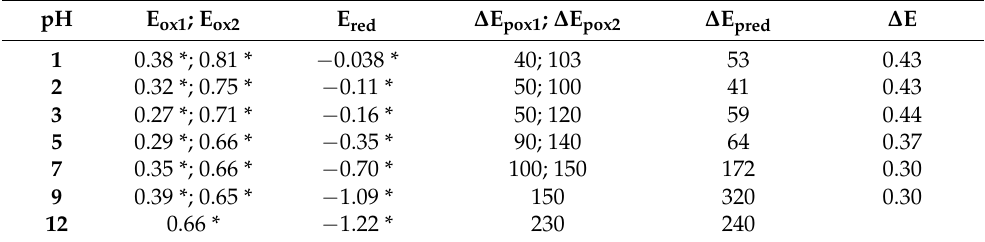
Figure 3. ( a ) Cyclic voltammogram of 0.5 mg ml − 1 N-CDs-160-8 and CG electrode in pH 7 buffer + 0.1 M NaClO 4 . Scan rate: 0.1 V s − 1 . Inset: Single-sweep voltammogram of N-CDs-160-8 CG background subtracted. ( b ) Cyclic voltammograms of 1 mg ml − 1 of N-CDs in pH 7 buffer + 0.1 M NaClO 4 . Scan rate: 0.1 V s − 1 . Table 2. Oxidation and reduction peak potentials vs. SCE (E oxn and E red /V), peak width ( ∆ E oxn ( ∆ E red /mV) and E 0x1 E ox2 potential separation ( ∆ E/V) for sample N-CQDs-160-8 at different pH val- ues.